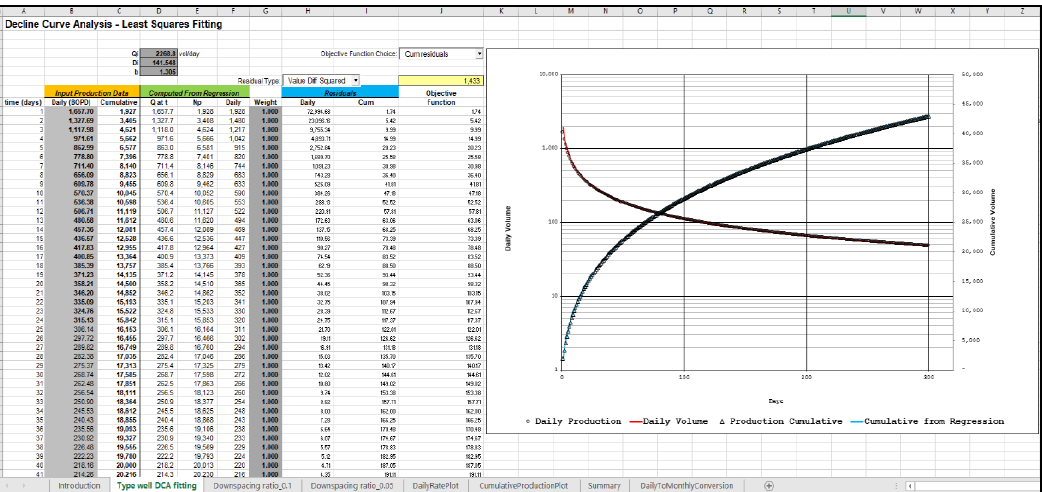
Figure A2. Screen capture of “Type well DCA fitting” tab to obtain forecast parameter to match type well production data .